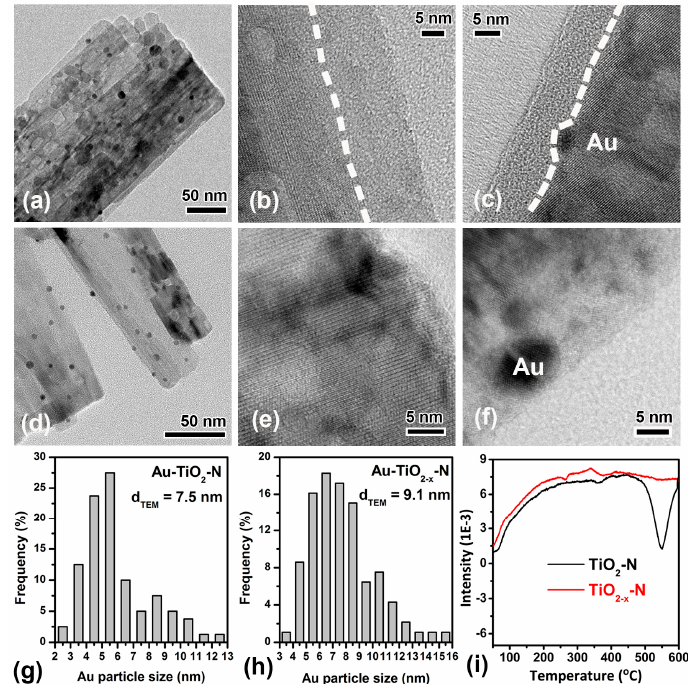
Figure 3. TEM images of Au ‐ TiO 2 ‐ N ( a ) and Au ‐ TiO 2 − x ‐ N ( d ). HRTEM images of TiO 2 − x ‐ N ( b ), Au ‐ TiO 2 − x ‐ N ( c ), TiO 2 ‐ N ( e ) and Au ‐ TiO 2 ‐ N ( f ). The dash line indicates the interface between the Au-TiO 2 − x -N ( c ), TiO 2 -N ( e ) and Au-TiO 2 -N ( f ). The dash line indicates the interface between the disordered layer and crystalline core. Surface ‐ averaged Au cluster diameters ( d TEM ) and cluster disordered layer and crystalline core. Surface-averaged Au cluster diameters ( d TEM ) and cluster diameter distributions of Au ‐ TiO 2 ‐ N ( g ) and Au ‐ TiO 2 − x ‐ N ( h ). H 2 ‐ TPR profiles of TiO 2 − x ‐ N and diameter distributions of Au-TiO 2 -N ( g ) and Au-TiO 2 − x -N ( h ). H 2 -TPR profiles of TiO 2 − x -N and TiO 2 ‐ N supports ( i ). TiO 2 -N supports ( i